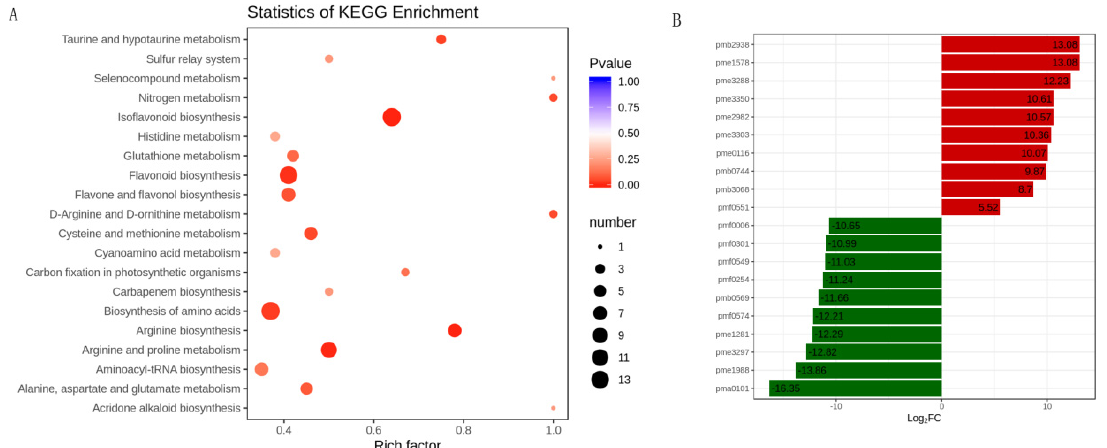
Figure 4. The differentially accumulated metabolites analysis in alfalfa after thrips infection. ( A ) Scatter plot of KEGG pathways in alfalfa after thrips infection to which the differentially accumulated metabolites were enriched. The degree of enrichment is shown by Rich factor, p -value, and the number of metabolites enriched in each pathway; ( B ) Top 10 up-accumulated (shown in red bars) and top 10 down-accumulated metabolites (shown in green bars) in alfalfa after thrips infection.